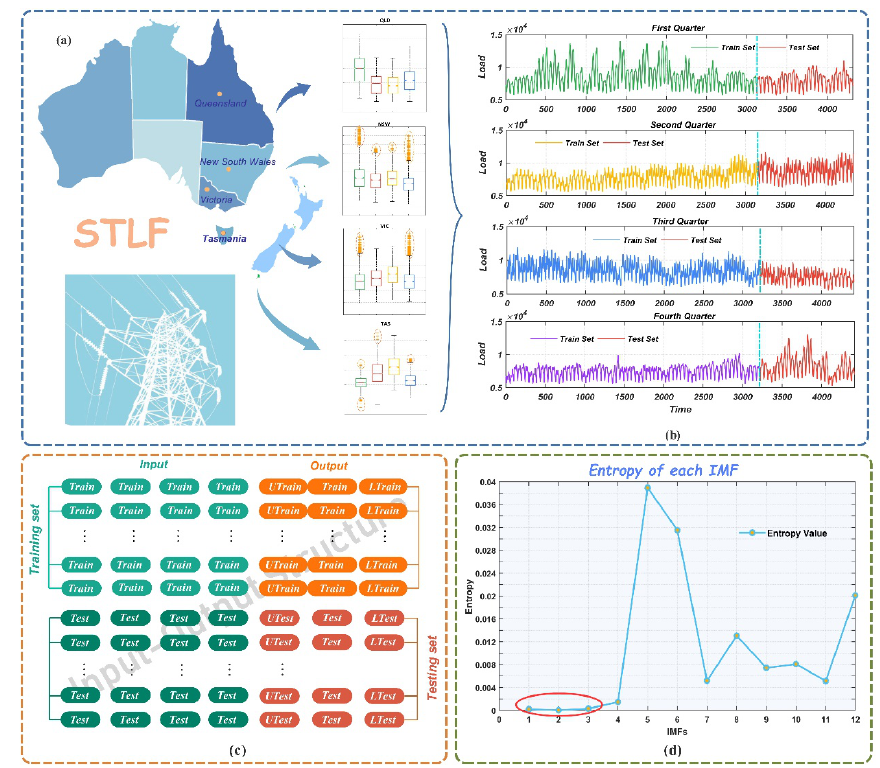
Figure 3. Data description of experiments. ( a ) Location of sample sites; ( b ) Division of train set and test set; ( c ) Structure of input set and output set; and ( d ) Entropy of each IMF). Table 1. Related parameters in hybrid model.